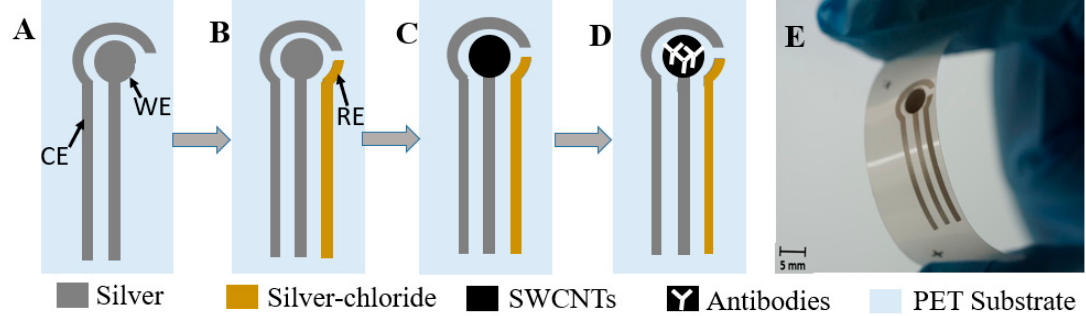
Figure 1. Schematic diagram of the fabricating process of the biosensors: ( A ) printing working electrode (WE) and counter electrode (CE), ( B ) printing WE with AgCl by alignment, ( C ) spray depositing single-walled carbon nanotubes (SWCNTs), ( D ) immobilization of antibody, and ( E ) final biosensor.